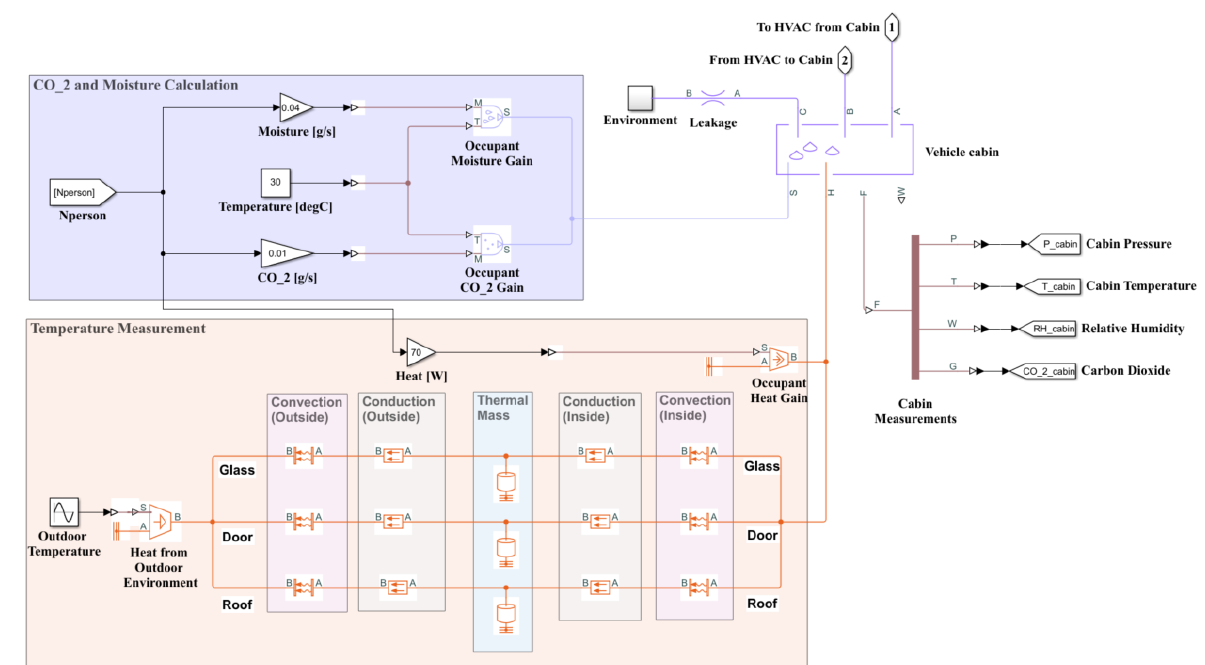
Figure 4. Simulink model for temperature and CO 2 calculation.